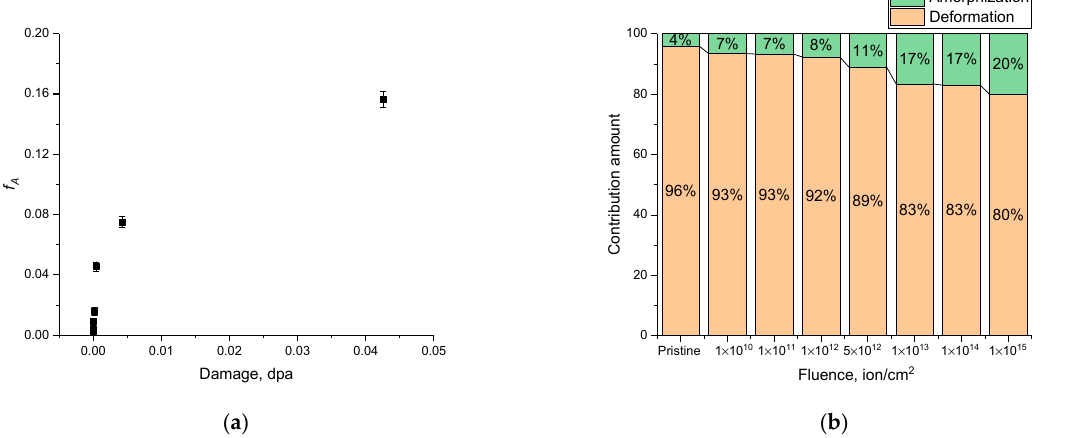
Figure 6. ( a ) Data on changes in the concentration of amorphous inclusions in the damaged layer of the alloy; ( b ) results of evaluation of the contributions of deformation distortions and amorphous inclusions in the damaged layer depending on the irradiation fl uence.